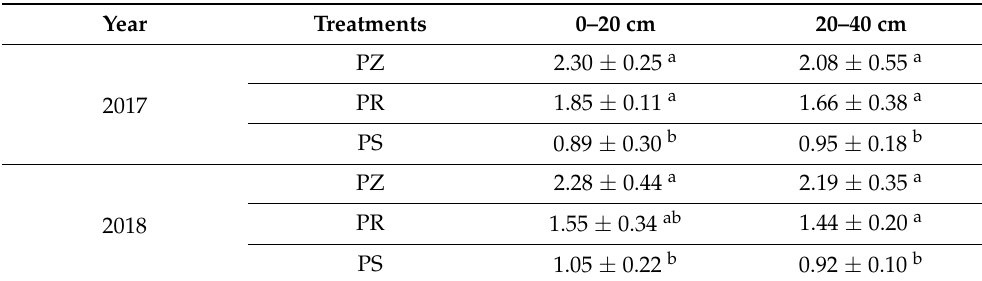
Figure 3. Position of cultivated horizon and plow pan in soil profile under rotary tillage and subsoiling. Table 4. Soil compaction of plough layer under different tillage methods (MPa).